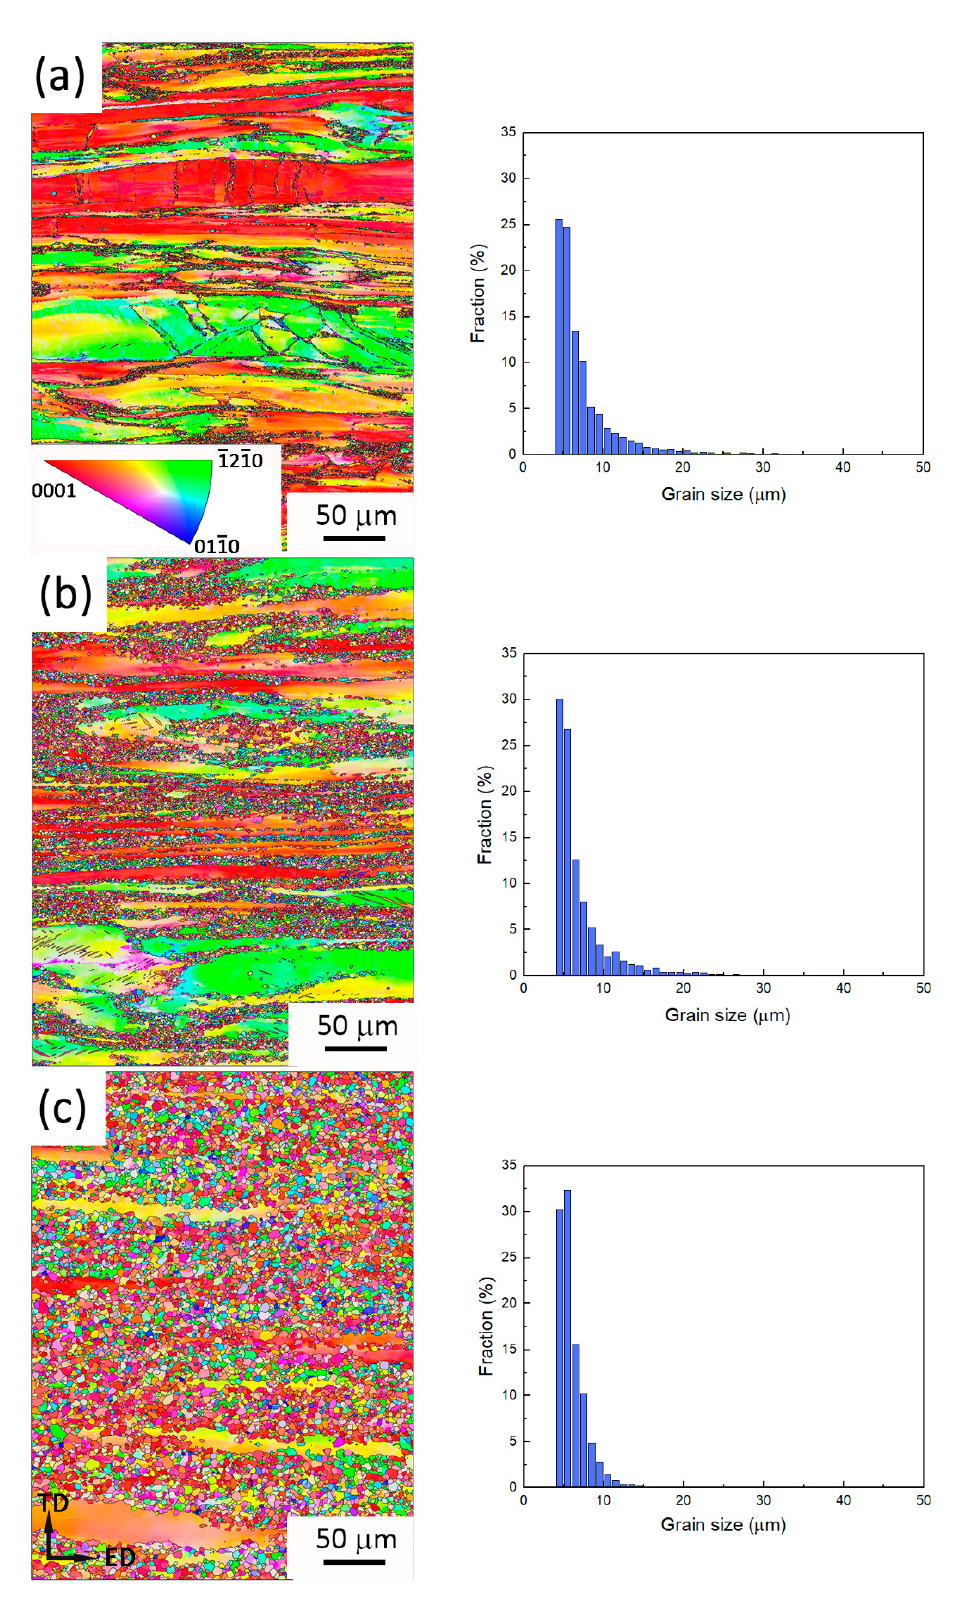
Figure 6. Inverse pole figure (IPF) maps on the ND plane of the ZX10 alloy (on the left) and corre- sponding grain size distributions (on the right) for the conditions: ( a ) extruded at 300 °C, ( b ) ex- truded at 350 °C, ( c ) extruded at 400 °C.